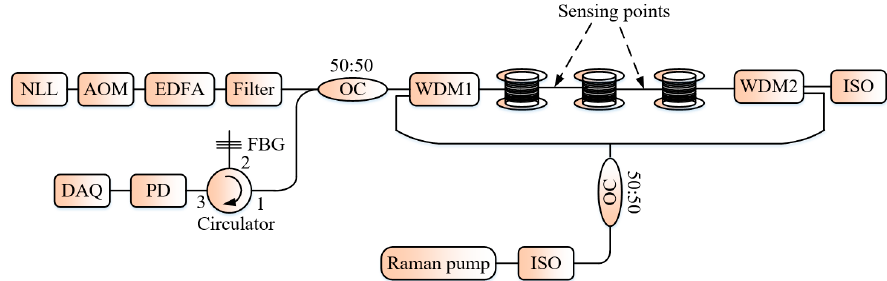
Figure 6. Experimental system of a Φ -OTDR system assisted with Raman amplification. WDM: wavelength division multiplexing, FBG: fiber Bragg grating filter.